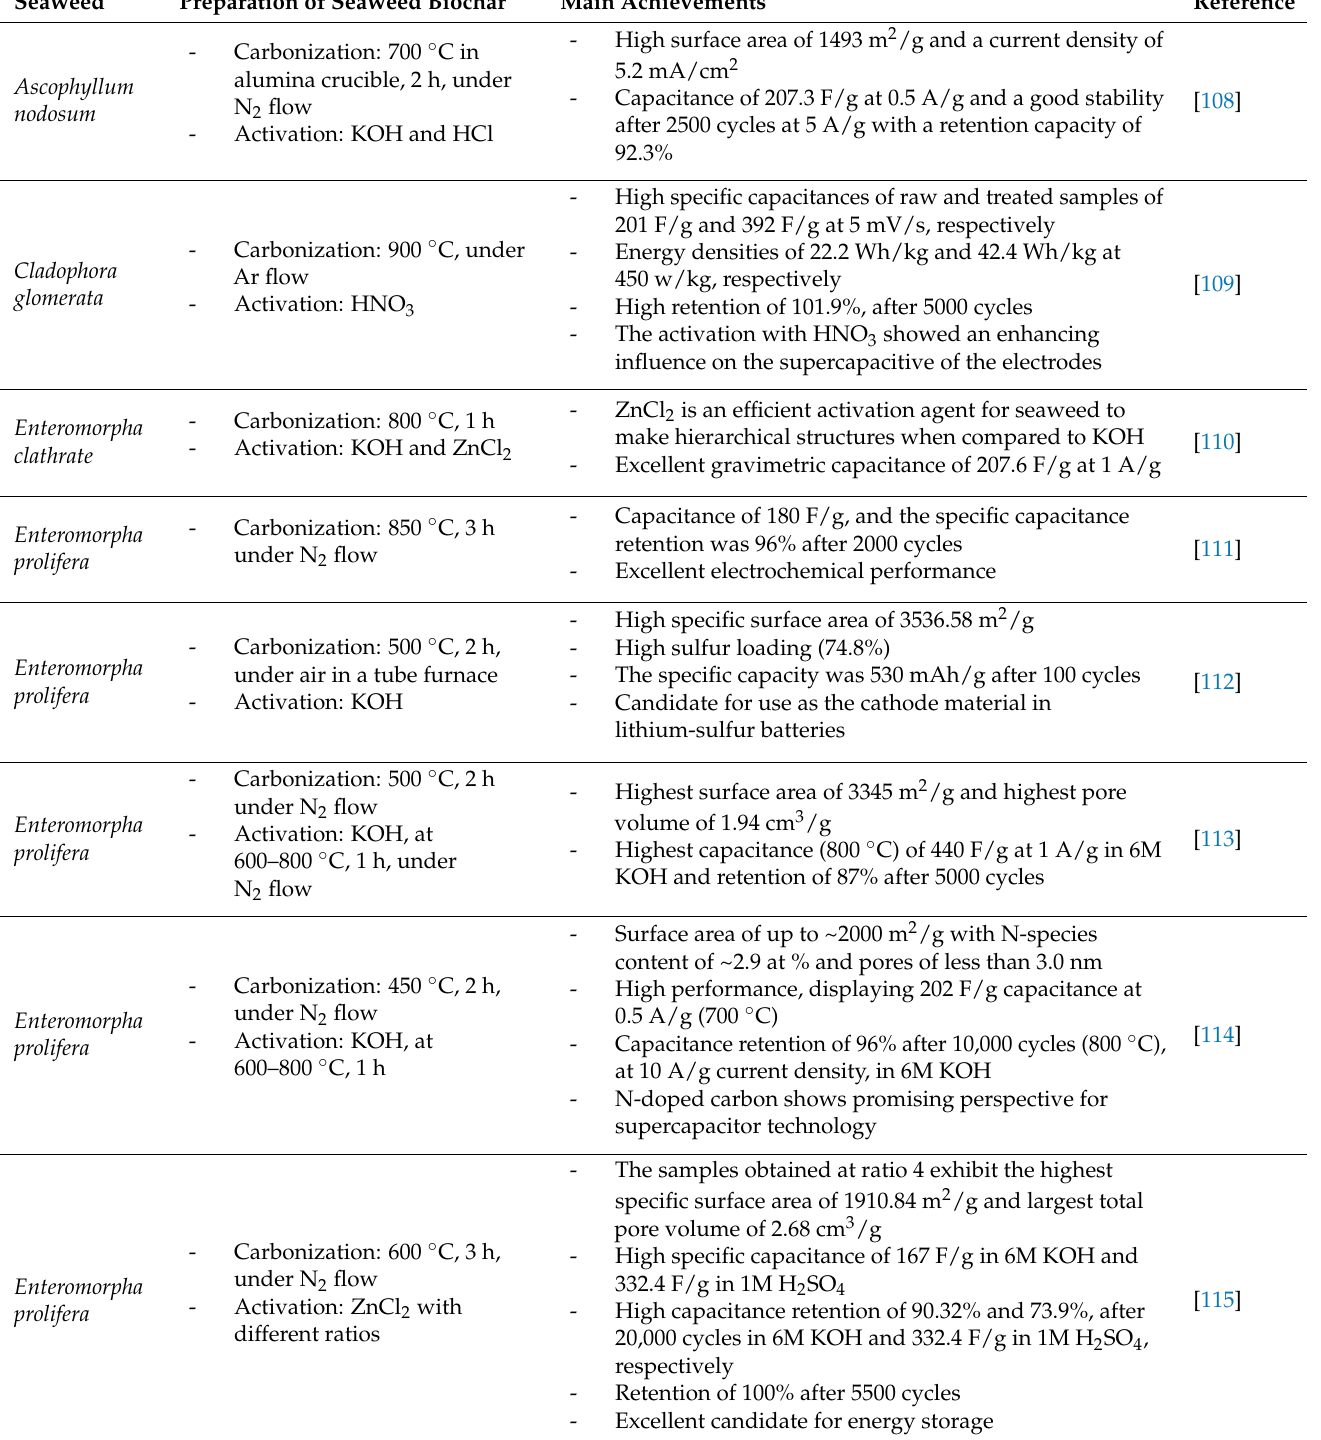
Table 5. Seaweed-derived carbons for high-performance energy-storage device